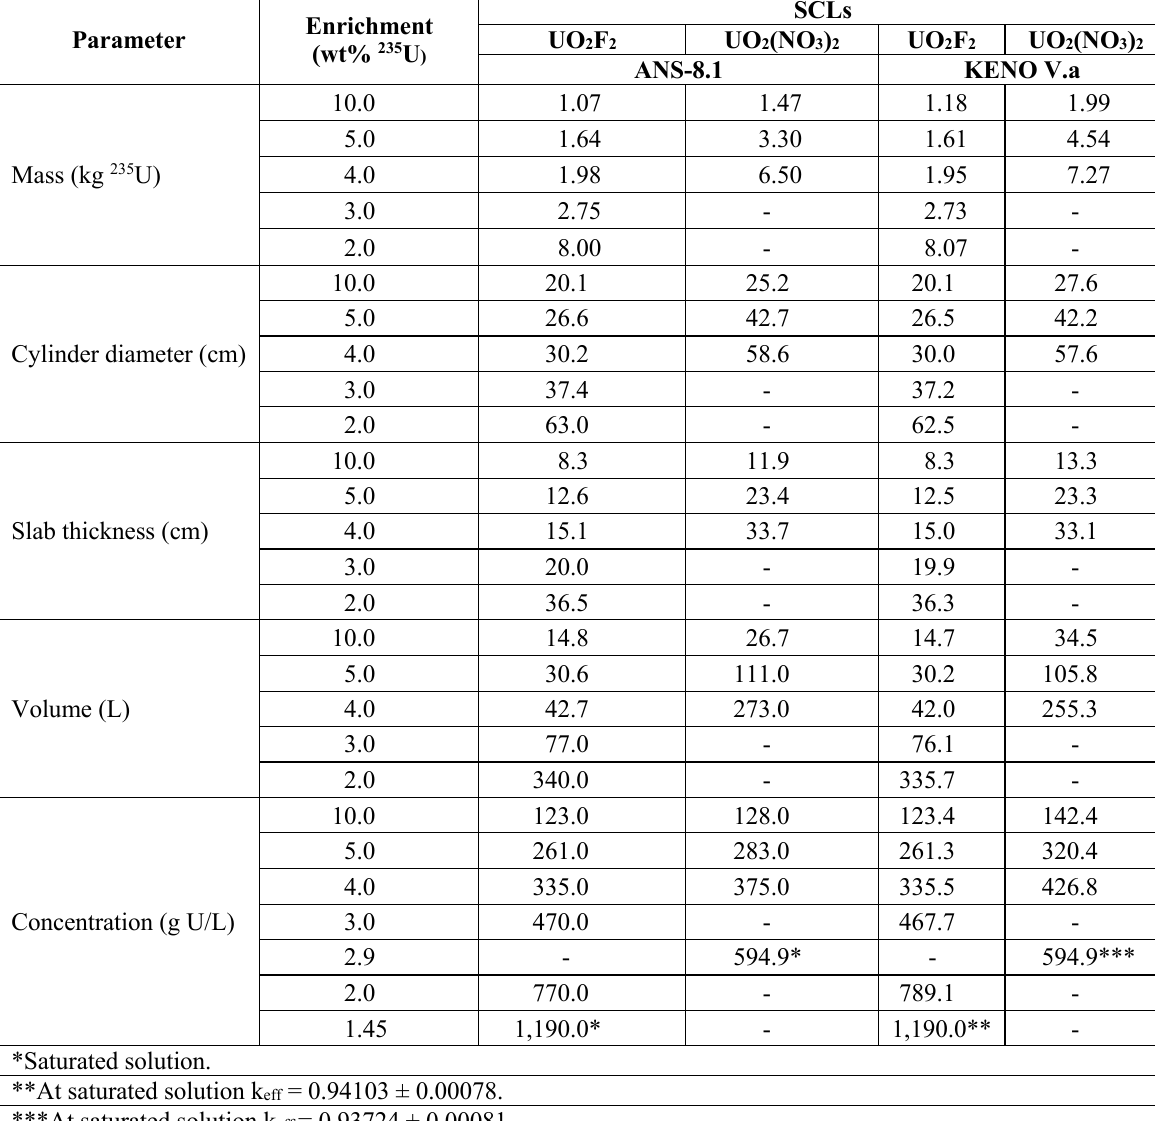
Table VI. SCLs for uniform aqueous solutions of low-enriched